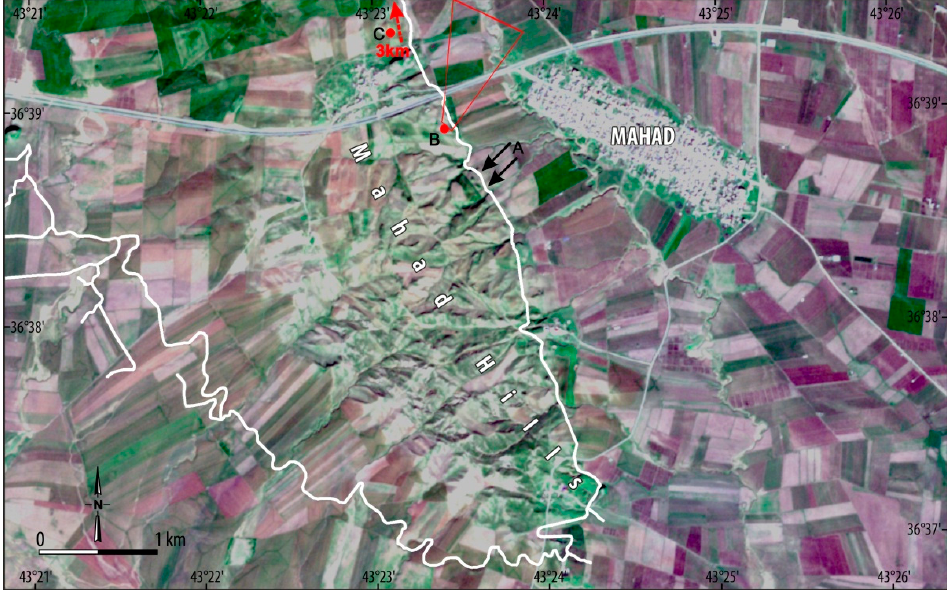
Figure 15. The Assyrian canal encircling the Mahad hills (© LoNAP). Background image © EU ‐